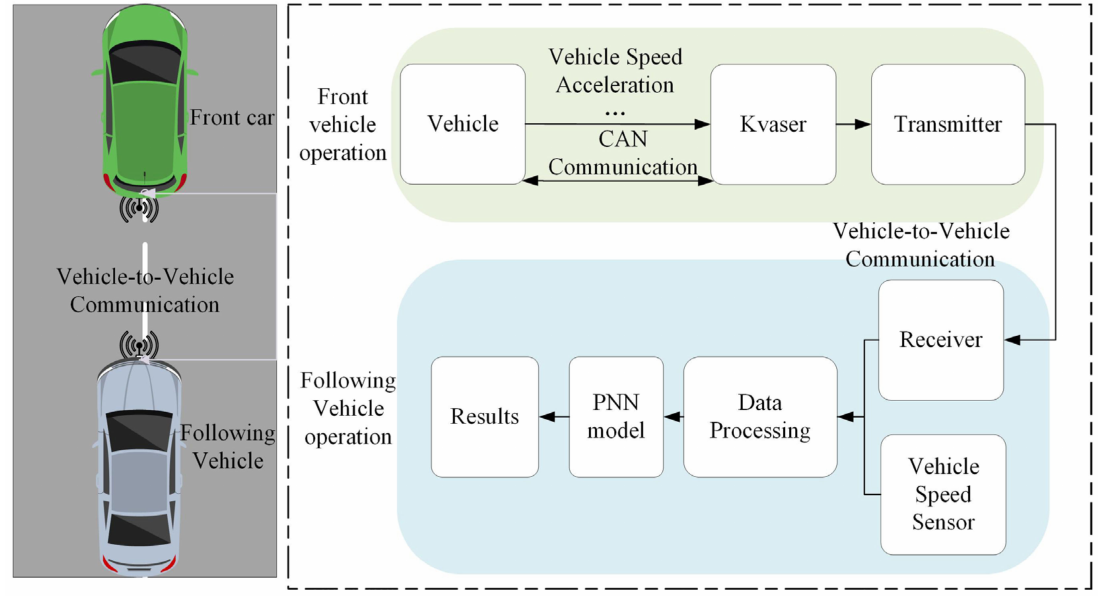
Figure 2. Simulation and real vehicle workflow